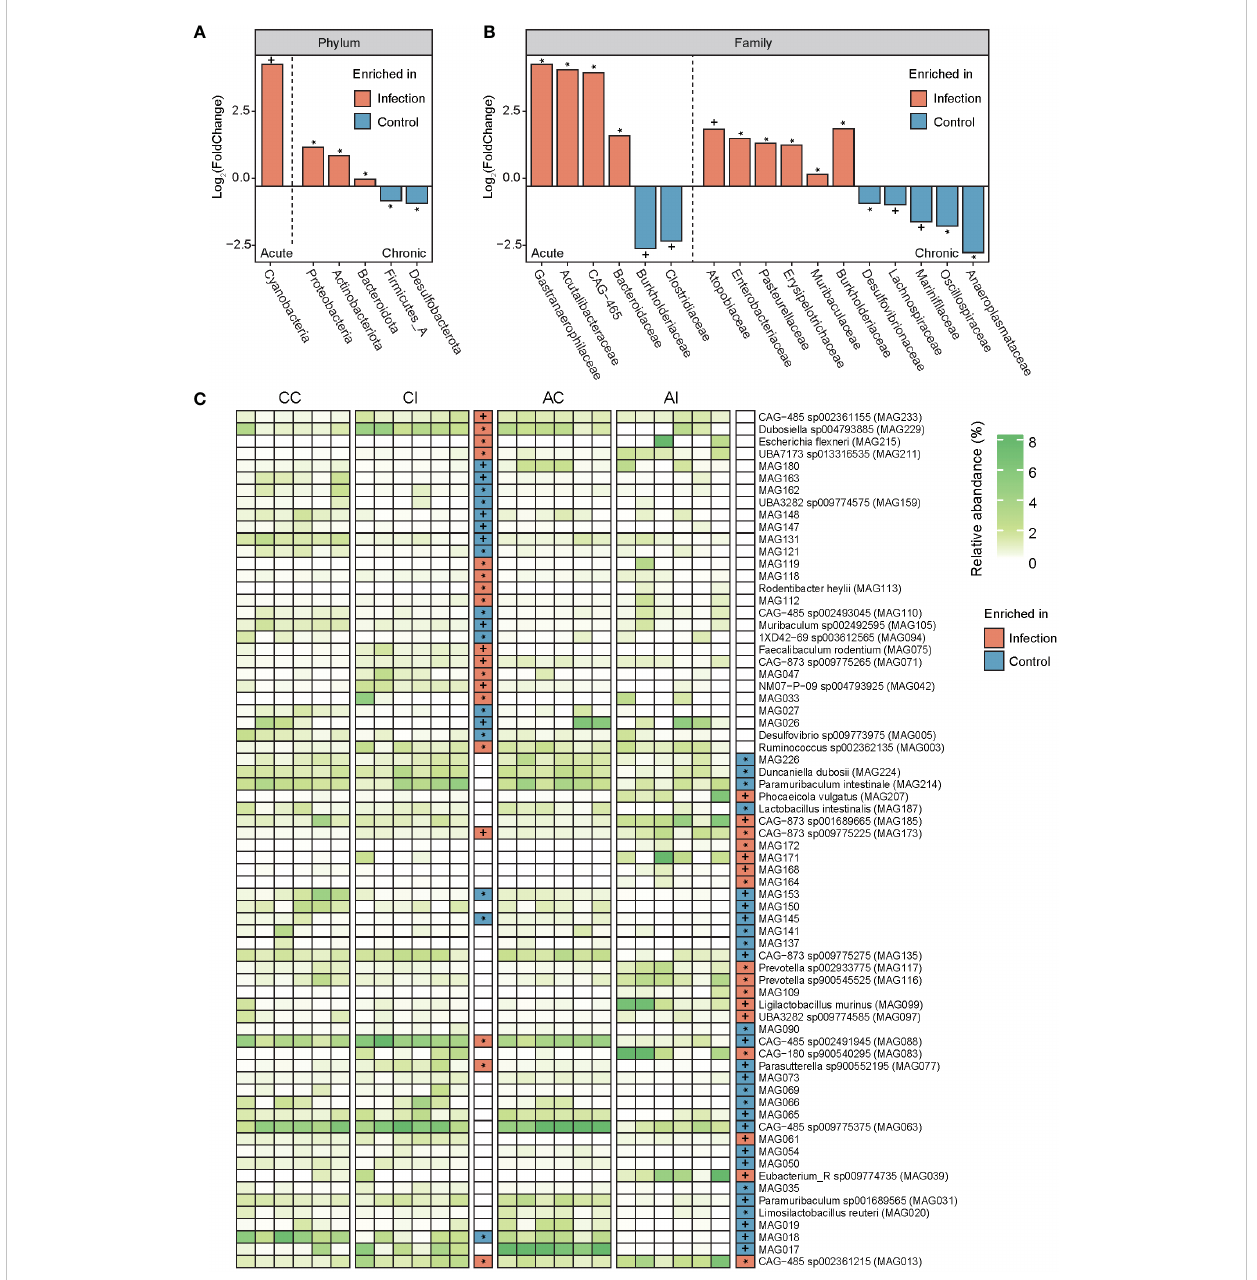
FIGURE 3 Comparison of the gut microbiota between infected and control groups at the phylum, family, and species levels. (A, B) Bar plots show the value of log 2 (FoldChange) of each feature (phyla and family) that has a signi fi cant difference. Orange displays taxa enriched in the infected group, and light blue indicates taxa enriched in the control group. The left part of each panel (left of the dashed line) represents the acute period of infection, and the right part of each panel (right of the dashed line) represents the chronic period of infection. Signatures indicate a statistical signi fi cance: * indicates p < 0.05; + indicates p < 0.01. (C) The heatmap displays the relative abundance of each MAG in each sample. The white to green transition denotes low to high relative abundance. In grids of intermediate and the rightmost parts, orange indicates features enriched in the infected group and light blue indicates features enriched in the control group. Signatures indicate a statistical signi fi cance: * indicates p < 0.05; + indicates p <